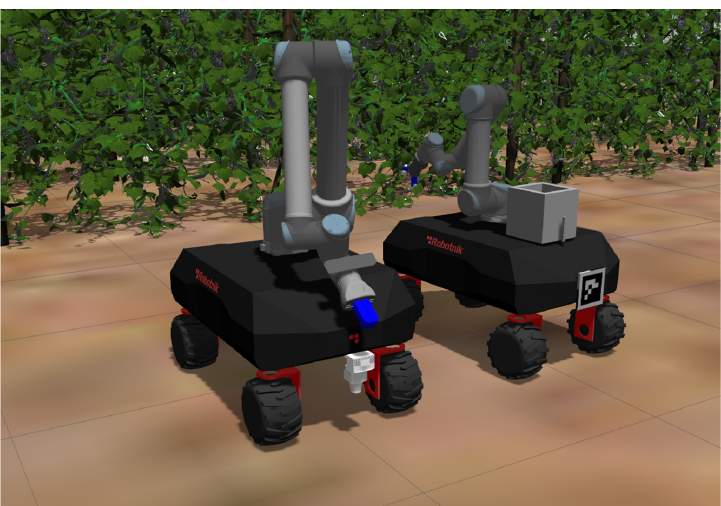
Figure 2. The simulated expert ( right ) and helper robots ( left ).